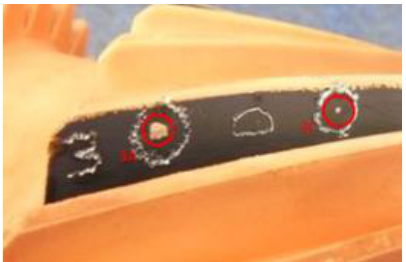
Figure 5. Gear sample with copper “ spots ” varying in size, representing chips locations close to pitch diameter of the gear teeth.